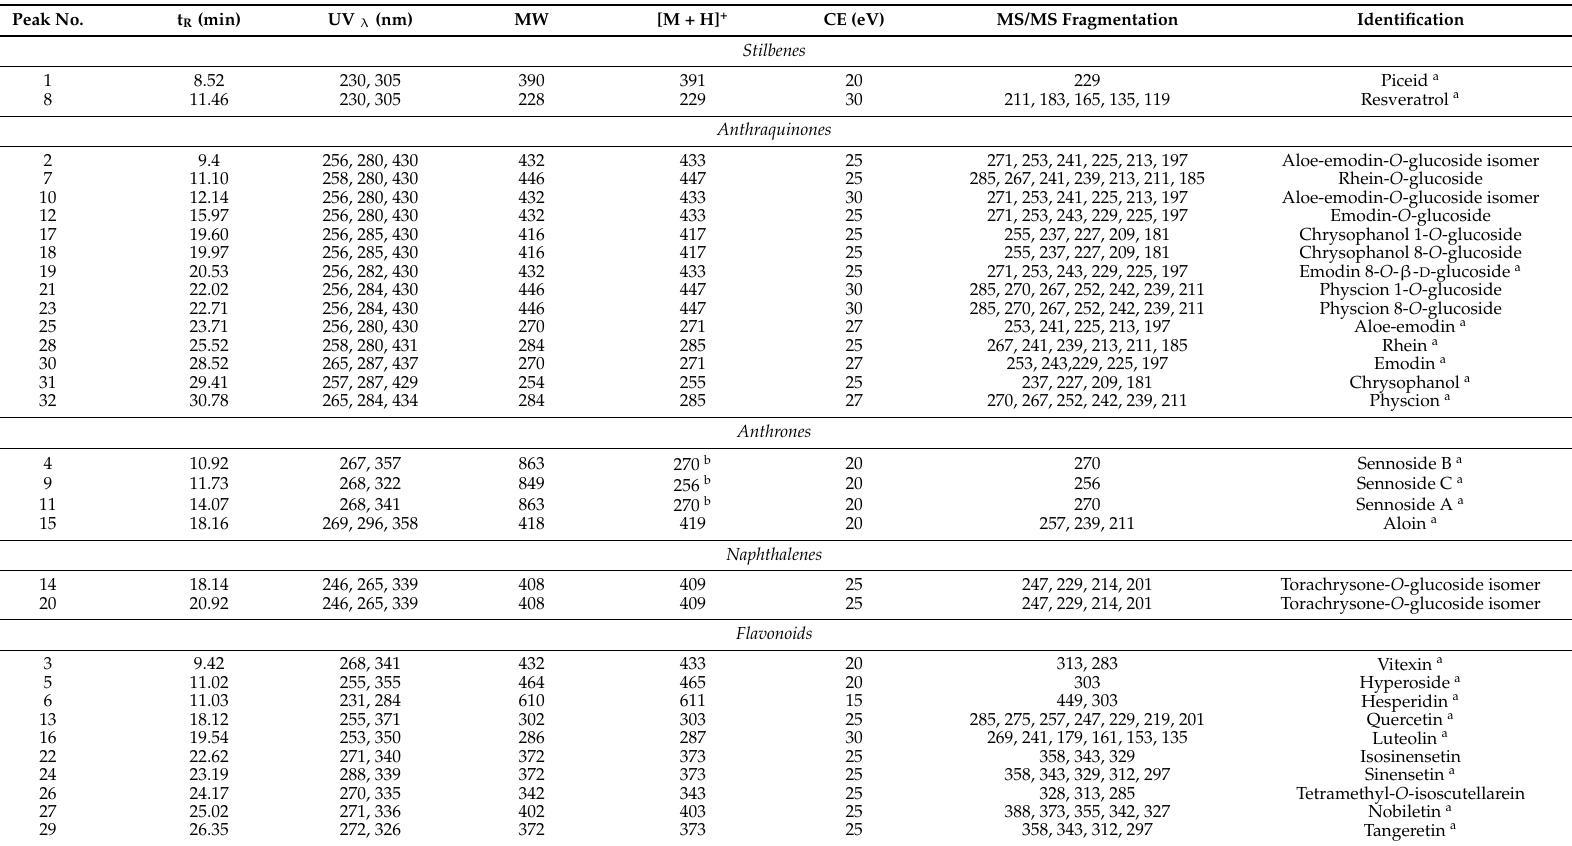
Table 1. Chemicals characterized in Danning tablets by UPLC-DAD-ESI-MS/MS analysis. Peak